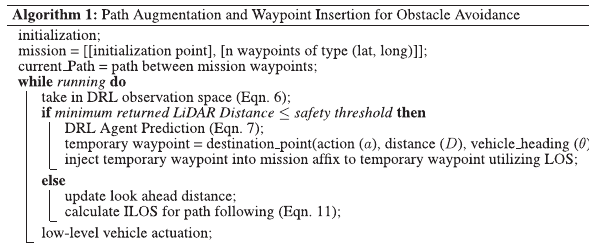
Algorithm 1. Path Augmentation and Waypoint Insertion for Obstacle Avoidance